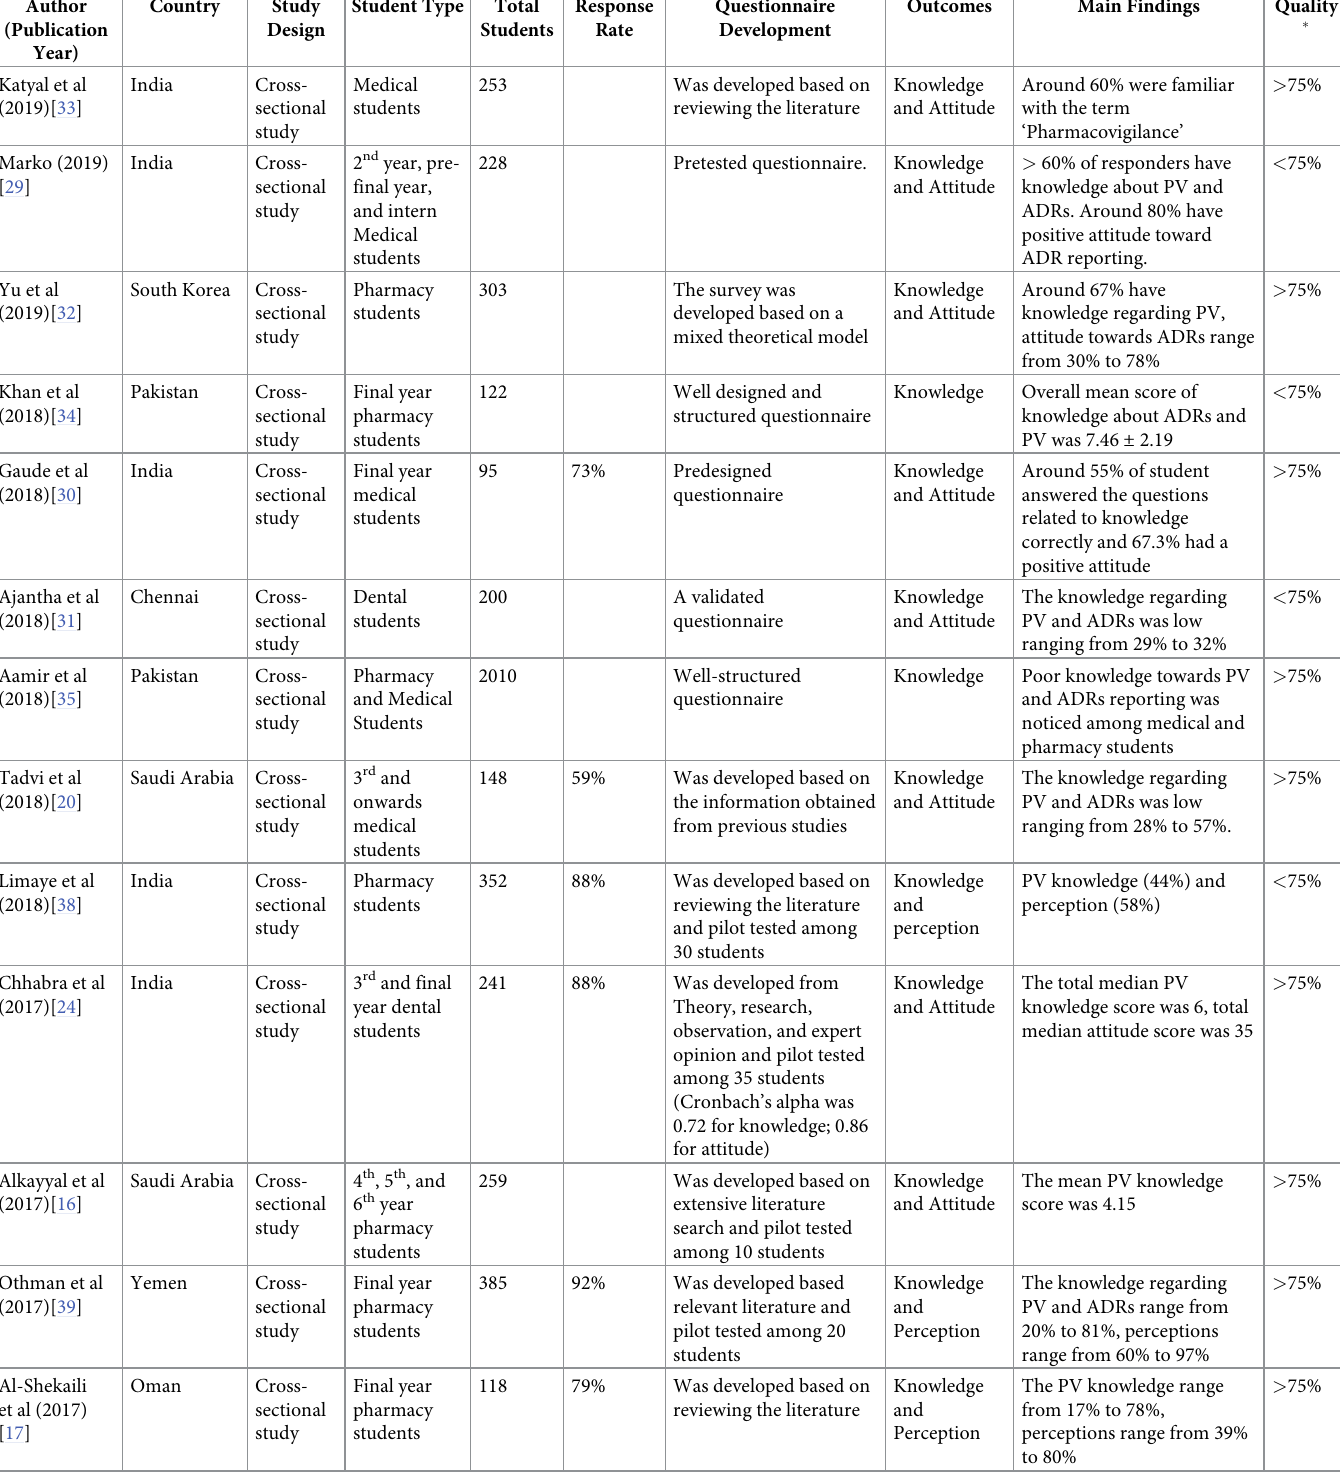
Table 1. Characteristics of included studies that measures knowledge, attitude, and perceptions of medical